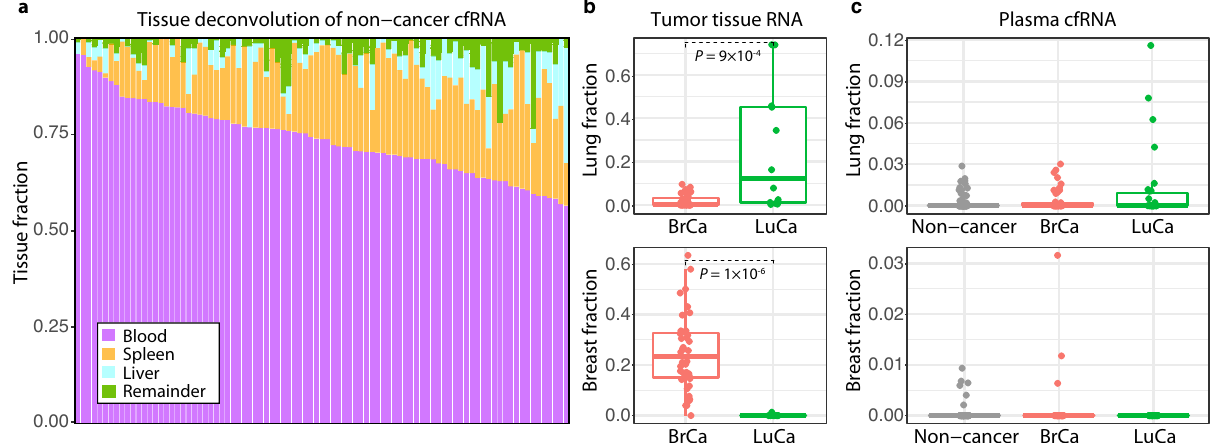
Fig. 2 Tissue deconvolution of RNA from plasma and tissue samples. a Tissue deconvolution for cell-free RNA (cfRNA) from 89 non-cancer plasma participants. Each stacked bar represents a single participant. b Lung and breast fraction distribution in RNA from matched tumor tissue obtained from 40 breast cancer (BrCa) and 11 lung cancer (LuCa) patients. P values from the two-sided Wilcoxon rank-sum method indicate signi fi cance levels for differences in tissue-speci fi c fractions across sample groups. c Lung and breast fraction distribution in plasma-derived cfRNA from different sample groups (46 BrCa, 28 LuCa, 89 non-cancer). Boxplots indicate the 25% (lower hinge), 50% (horizontal line), and 75% quantiles (upper hinge) of the tissue fraction distribution, with whiskers that indicate observations outside the hinge ± 1.5 x interquartile range (IQR). Outliers (beyond 1.5 × IQR) are plotted